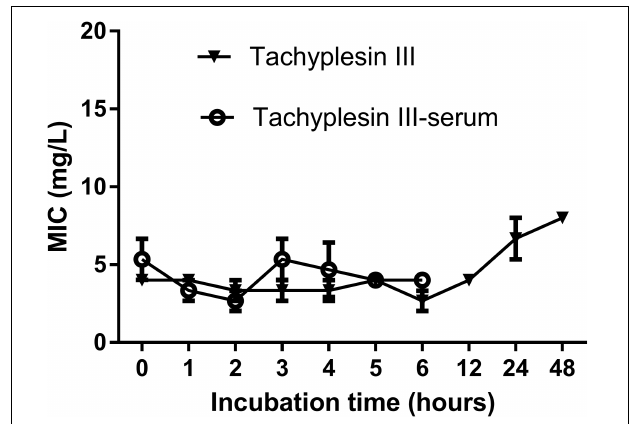
FIGURE 1 | Serum stability of tachyplesin III. Tachyplesin III (2 mg/ml) was incubated in either sterile deionized water or mouse serum at 37 ◦ C for various lengths of time, aliquots were taken, and MICs against DH5 α cells were tested. Stability of the MIC indicates the stability of tachyplesin III.